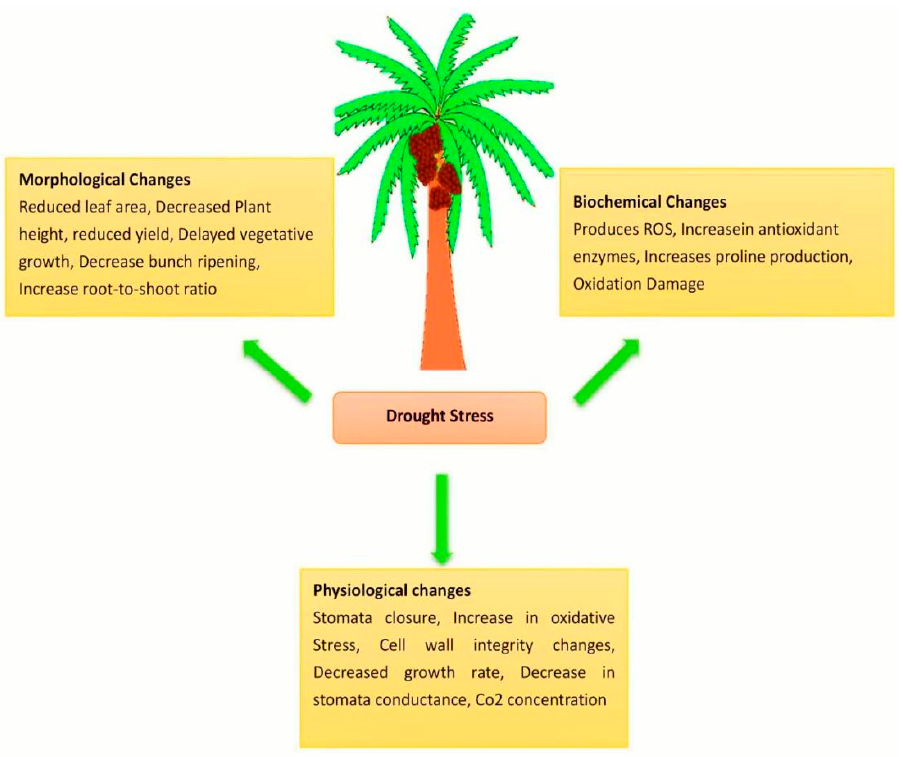
Figure 2. Drought tolerance in oil palm. Drought stress causes significant changes in morphological, biochemical, and physiological.